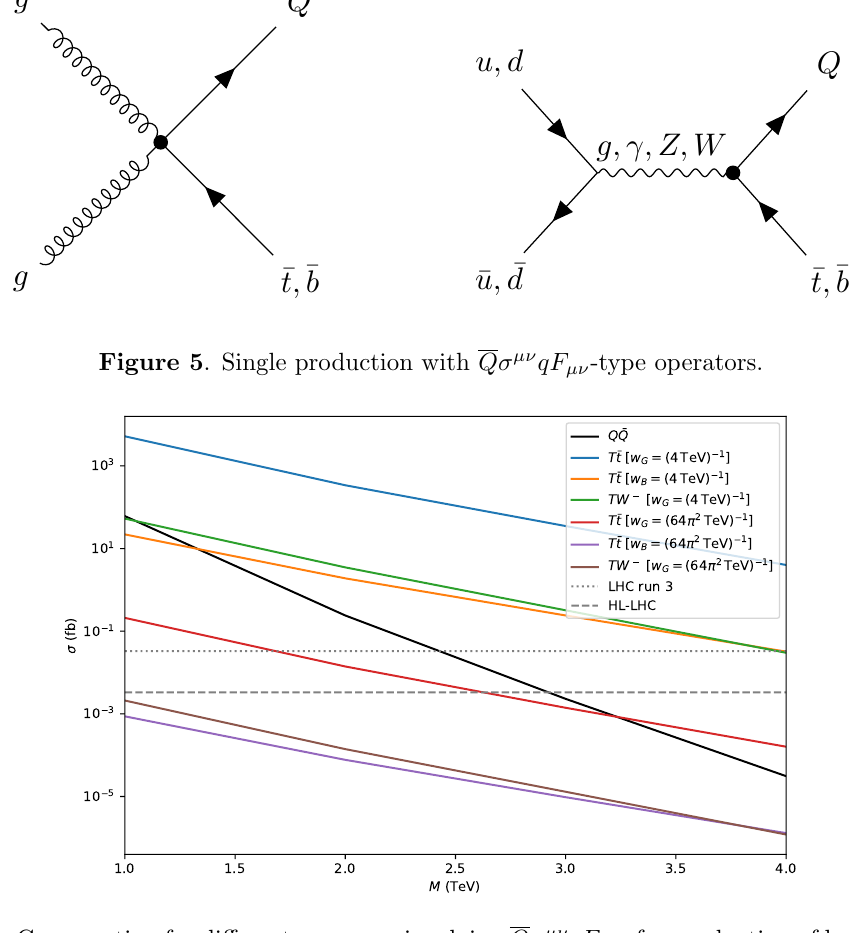
Figure 6 . Cross section for di(cid:11)erent processes involving Q(cid:27) (cid:22)(cid:23) qF (cid:22)(cid:23) , for production of heavy quarks in the U model, with a center-of-mass energy of 14